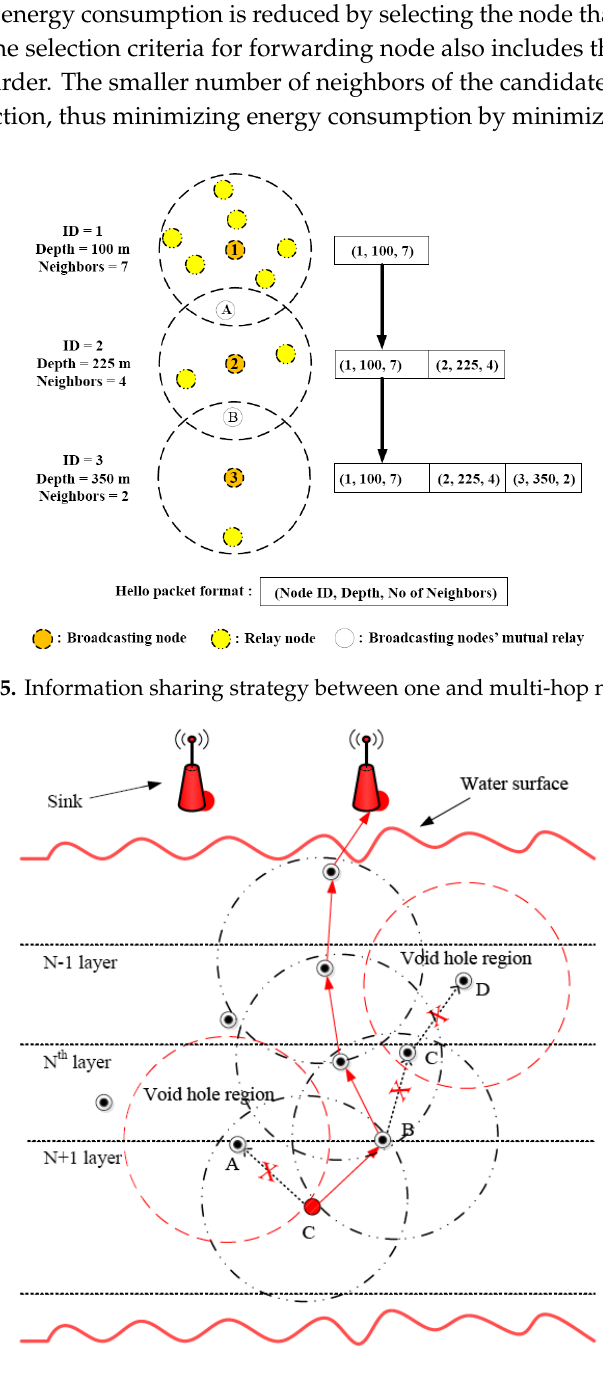
Figure 16. Selection of relay node in EP VIR 3 and BF SPR 3